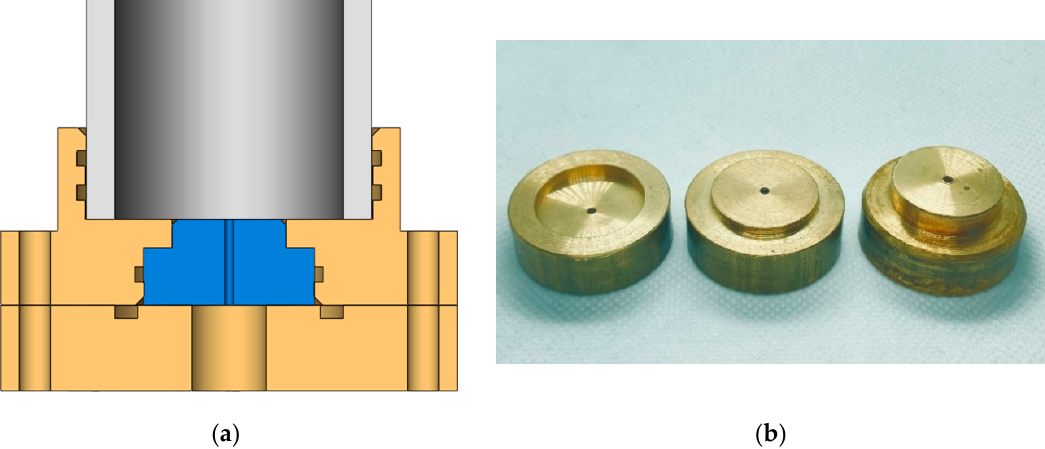
Figure 2. ( a )—CAD cut-away of the injector assembly on the chamber: injector assembly (orange), injector orifice (blue), and chamber (grey) ( b )—Photo of the Injector No. 1, No. 2, and No. 3.